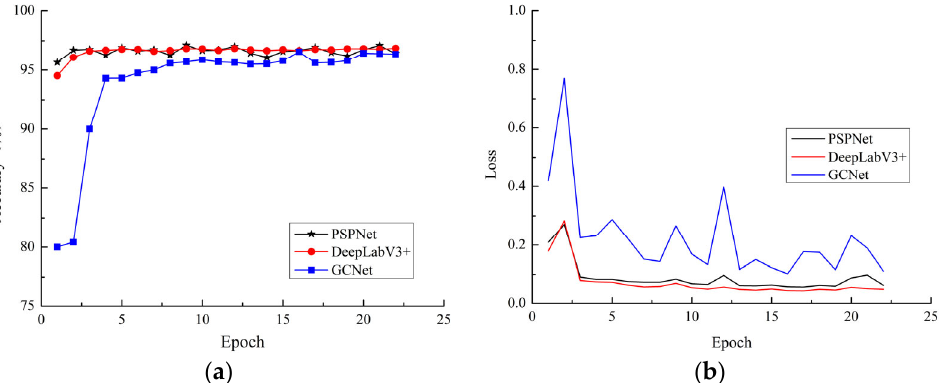
Figure 8. Convergence of different models: ( a ) variation of pixel accuracy with training rounds; ( b ) variation of validation set loss values with training rounds.